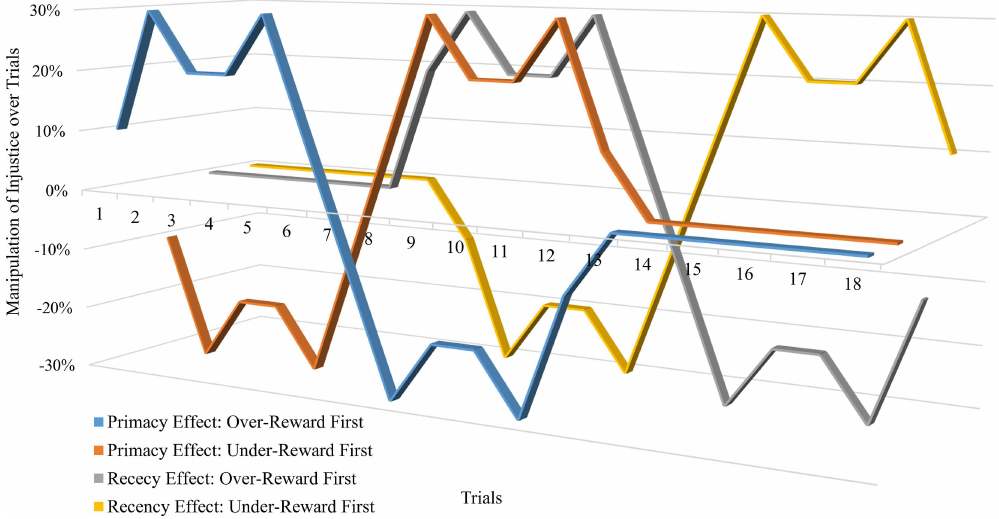
Fig 1. Manipulation Schedule of